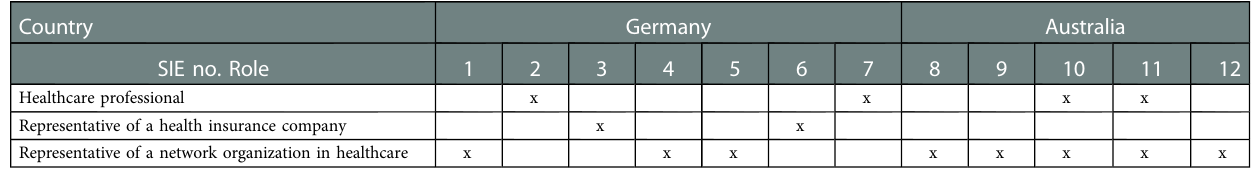
TABLE 3 Country and expert ’ s status per interview with the structure-interview experts (SIEs). Country